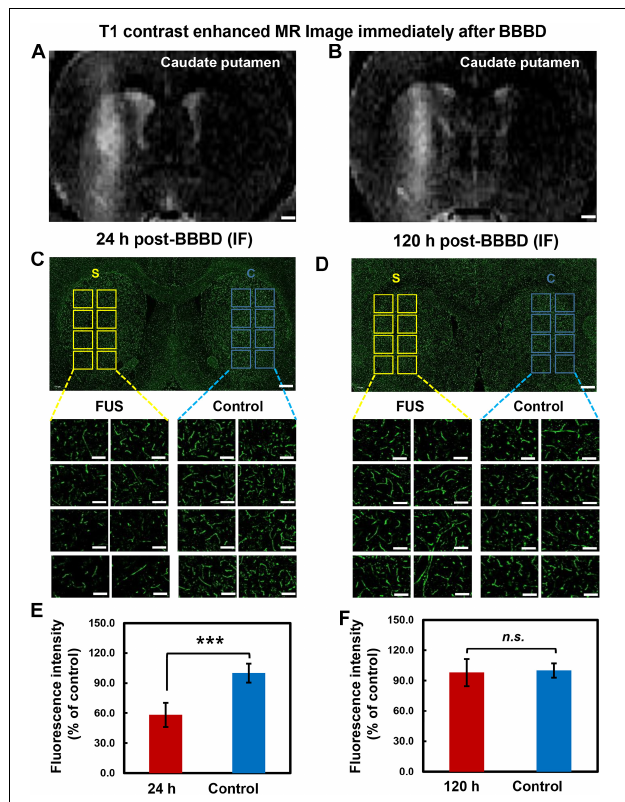
FIGURE 4 | Immunolabeling of P-gp in brain tissue after BBBD. Representative post-sonication T1-weighted MR images of animals in (A) group 1 (scarified at 24 h post-BBBD), (B) group 2 (scarified at 120 h post-BBBD). (C,D) P-gp immunostaining was performed in brain tissue at 24 h post-BBBD (C) and 120 h post-BBBD (D) . Each 8 ROIs were selected for BBBD region (S, yellow square box) and control region (C, blue square box). The selected ROIs were magnified 20 times (original magnification, × 20) (E,F) The intensity of P-gp expression were measured and converted to relative intensity compared with control. It was presented as the mean ± standard deviation (SD) ( n = 8, ∗∗∗ P < 0.001, n.s.; no significance) Scale bar was represented 1 mm in (A,B) , or 50 µ m in (C,D)